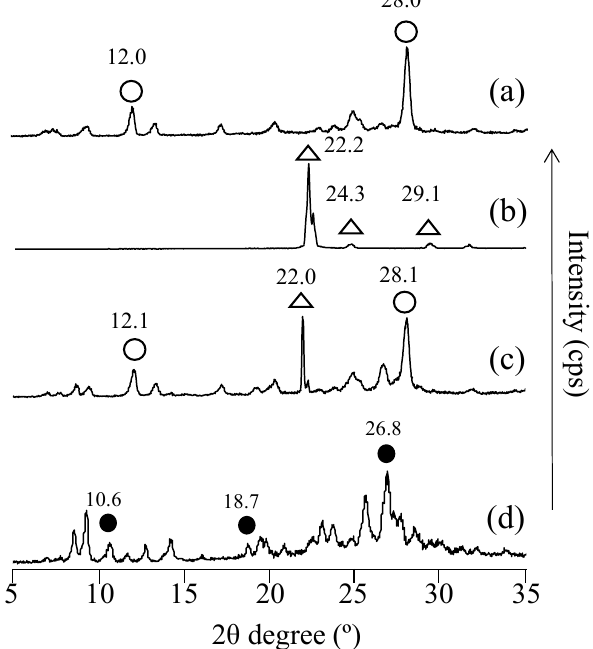
Figure 5. PXRD patterns of EA/UR systems. ( a ) EA; ( b ) UR; ( c ) PM (EA/UR = 1/1); and ( d ) EVP (EA/UR = 1/1). 〇 EA, △ UR, and ● new peak.